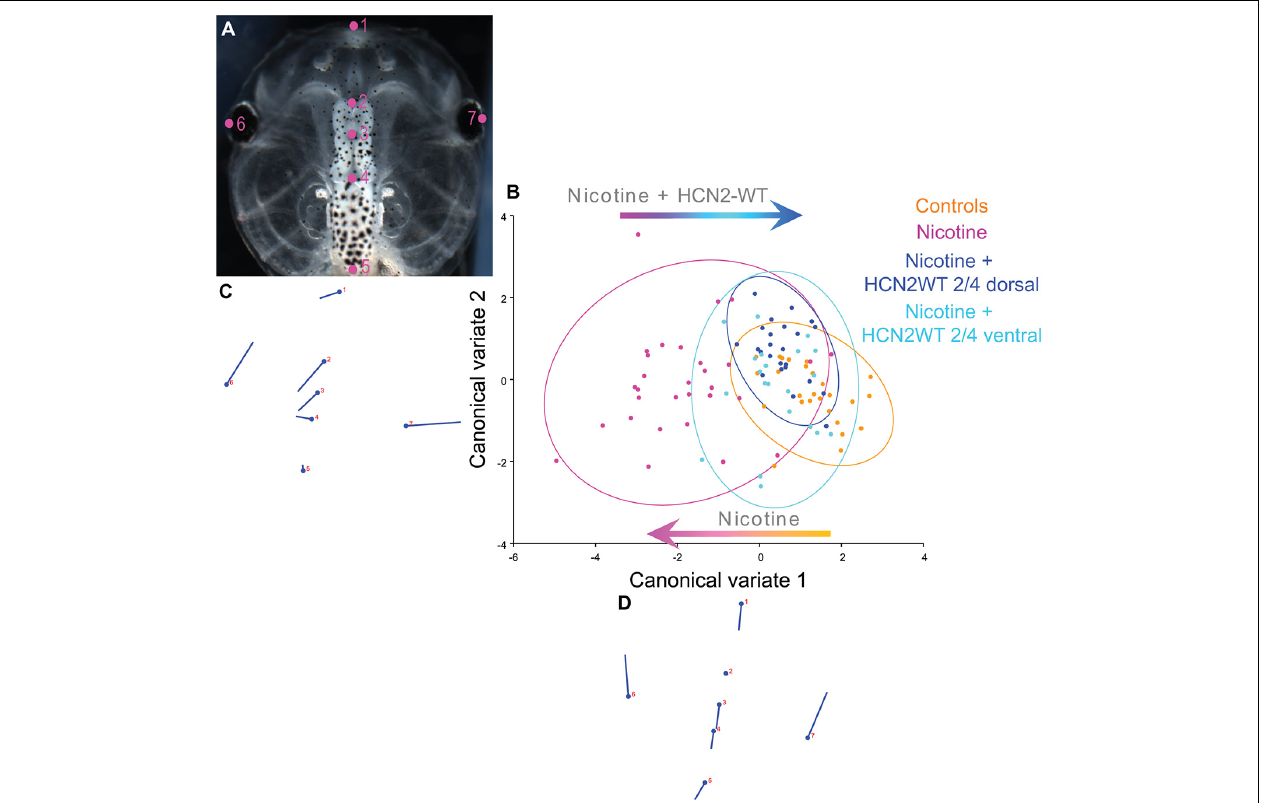
FIGURE 2 | Both local (CNS) and distant (non-CNS) expression of HCN2 channels restore brain size in proportion to head shape in nicotine-exposed embryos. (A–D) Morphometrics canonical variate analysis of brain size in proportion to head shape of stage 45 tadpoles. Representative image of a stage 45 control tadpole (A) illustrating the seven landmarks used in this analysis. (B) Canonical variate analysis, showing confidence ellipses for means at a 0.95 probability of shape data. Confidence ellipses are colored to correspond with treatment as indicated. N > 20 for each group. Procrustes distances: Control vs. nicotine = 0.1, Control vs. nicotine+dorsal-HCN2-WT = 0.04, Control vs. nicotine+ventral-HCN2-WT = 0.05. ANOVA of centroid shape between the controls, nicotine treatment, and nicotine+HCN2-WT (both dorsal and ventral) showed significant differences between the groupings (dorsal microinjection— F = 10.67, p < 0.0001; ventral microinjection— F = 9.0, p < 0.0001). (C,D) Canonical variate axis legend showing the movement of each of the seven landmarks. Each ball represents the landmark as indicated by the number and the accompanying stick represents the direction and extent of movement of that particular